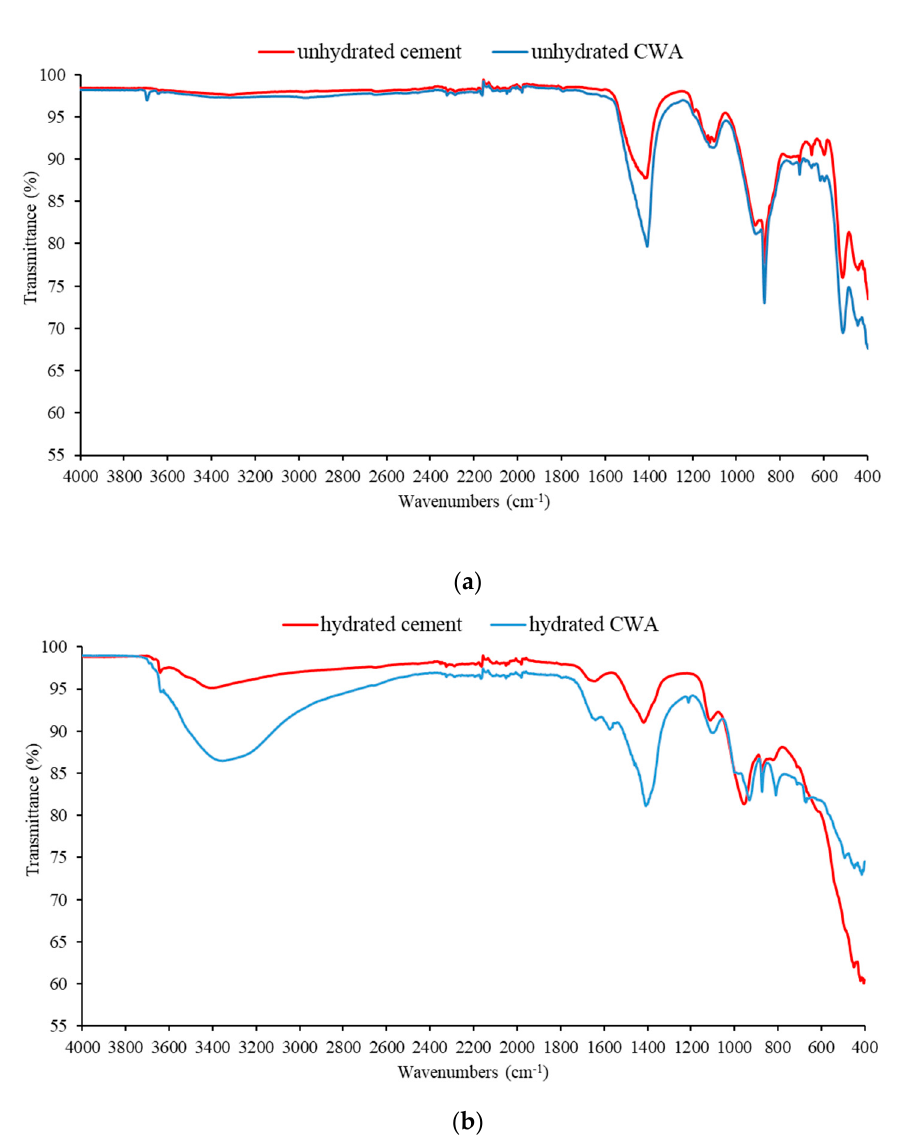
Figure 9. FTIR of cement and CWA: ( a ) before hydration and ( b ) after 95 days of hydration .